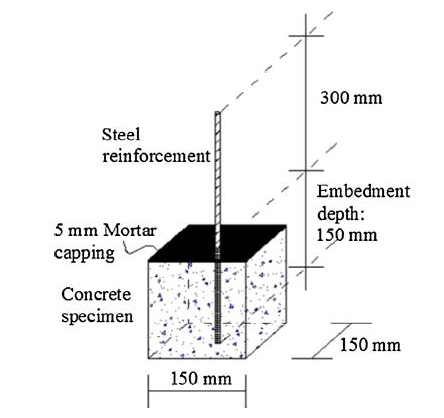
Figure 2. Schematic diagram of the